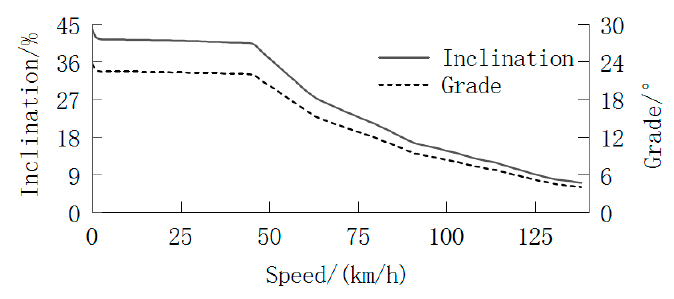
Figure 3. Simulation Results of Vehicle Climbing Performance.